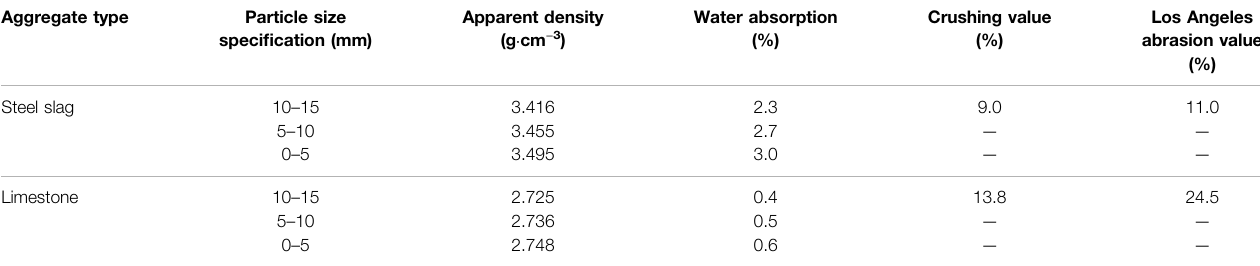
TABLE 1 | Measured parameters of steel slag and limestone aggregates.